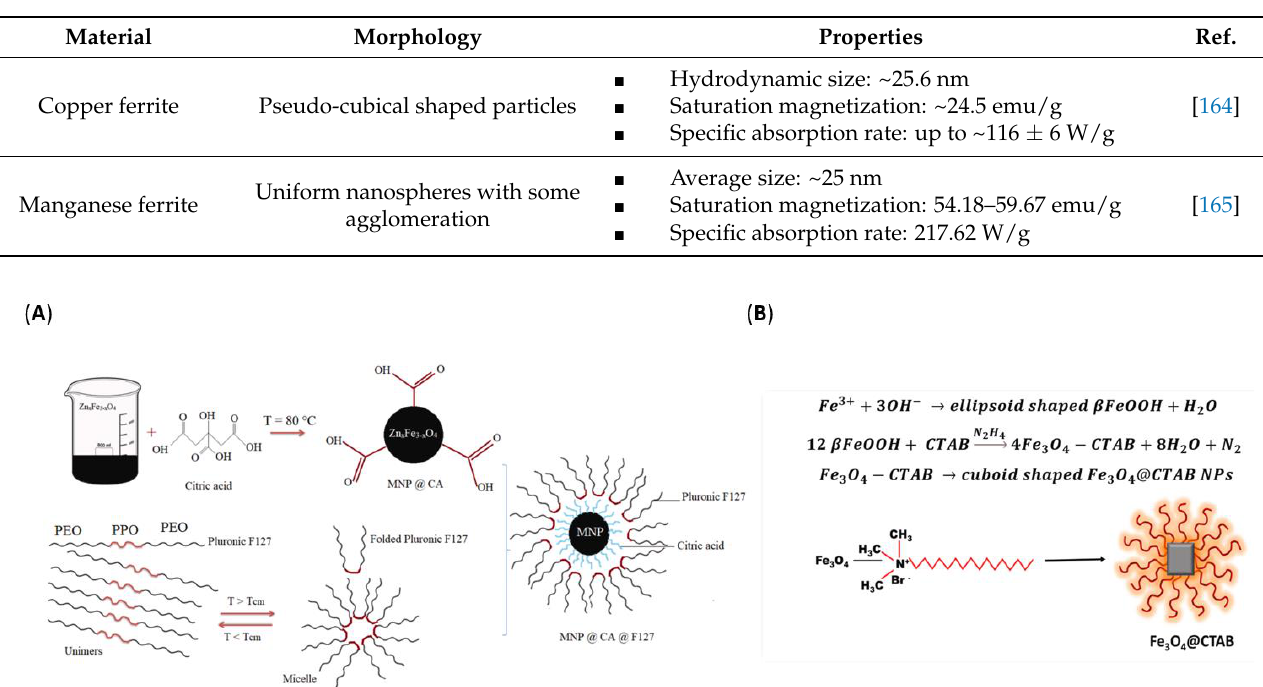
Figure 10. ( A ) Schematic representation of the surface modification of the magnetic nanoparticles with citric acid (CA) and pluronic F127. Reproduced with permission from [159], Elsevier B.V., 2022. ( B ) Schematic representation of the formation mechanism of Fe 3 O 4 @CTAB nanocuboids. Reprinted with permission from [162], Elsevier B.V., 2021.